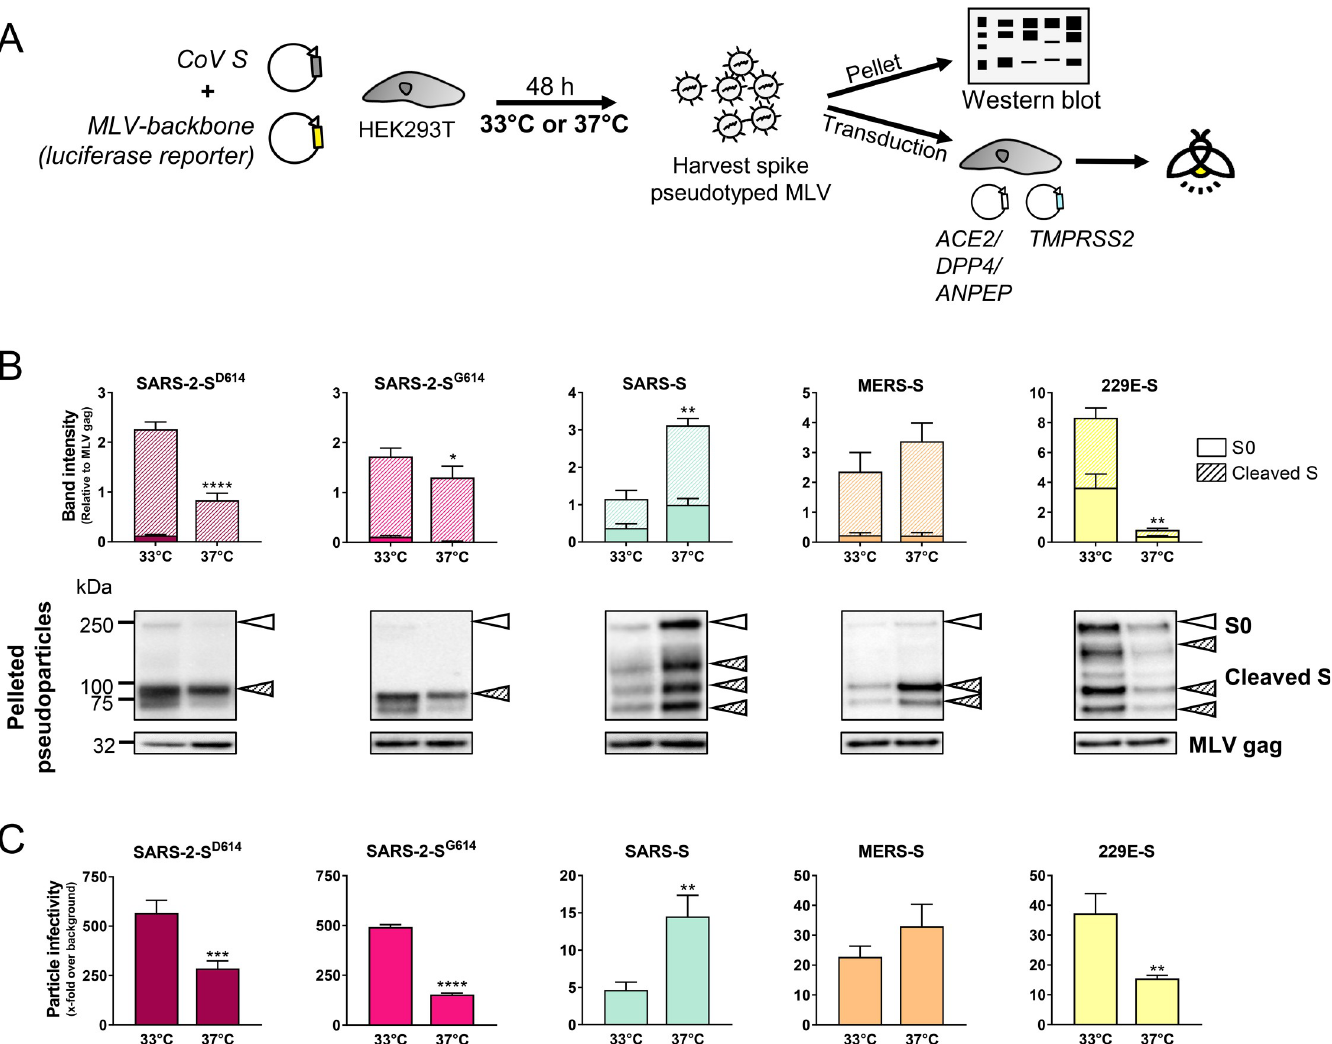
Fig 2. S protein level and infectivity of pseudovirions are dependent on the production temperature. (A) Experiment set-up. S-bearing pseudoviruses were produced in HEK293T cells at either 33˚C or 37˚C, and the released particles were pelleted to determine S content by western blot. In parallel, they were used to transduce HEK293T target cells expressing the appropriate receptor and TMPRSS2. (B) The graphs show S content relative to that of MLV-gag (mean ± SEM of four independently produced stocks). Representative blots show bands of uncleaved and cleaved S protein. (C) Particle infectivity was measured by luminescence read-out at day 3 post transduction (mean ± SEM of three independently produced stocks). � , P � 0.05; �� , P � 0.01; ��� , P � 0.001; ���� , P � 0.0001 (two-tailed unpaired t-test; 37˚C versus